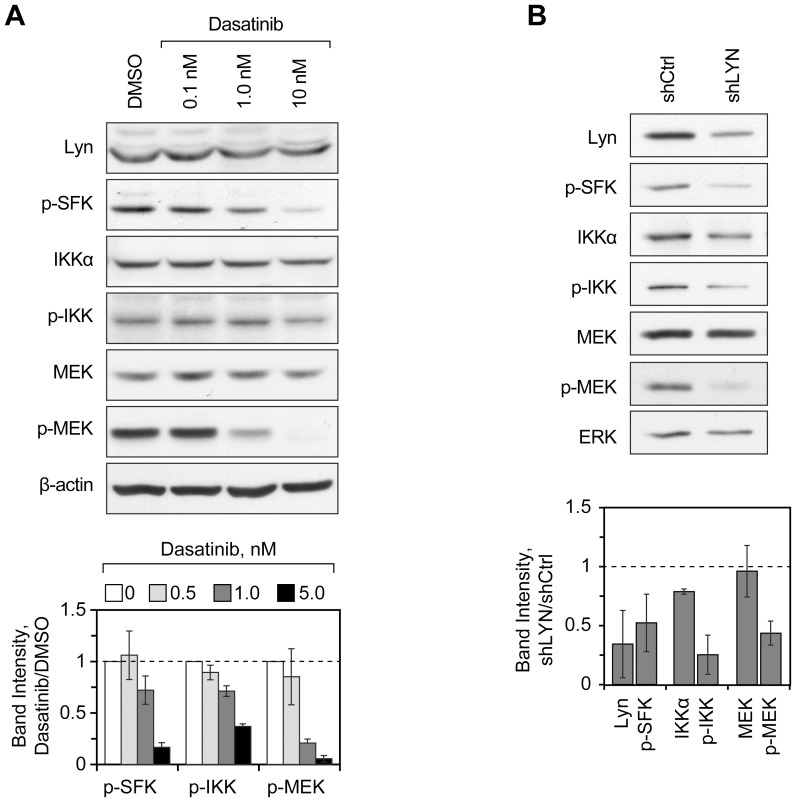
Lyn drives activation of MEK and increases activation of IKKα in MYL-R cells.(A) MYL-R cells were treated for 1 hour with dasatinib, as indicated, and lysates were analyzed by immunoblot with the antibodies indicated. Lyn phosphorylation was detected by p-SFK (Y416). For densitometry, the band densities of p-SFK, p-MEK and p-IKKα were normalized against the β-actin loading control and were plotted relative to the DMSO treatment. Error bars, SE (N = 3). (B) MYL-R cells were transduced with non-targeting shRNA (shCtrl) or shRNA directed against Lyn (shLyn) and lysates were analyzed by immunoblot with the antibodies indicated. Lyn phosphorylation was detected by p-SFK (Y416) antibody. For densitometry, the band densities of p-IKKα and p-MEK were plotted relative to total IKKα and MEK protein expression. Error bars, SE (N = 2).